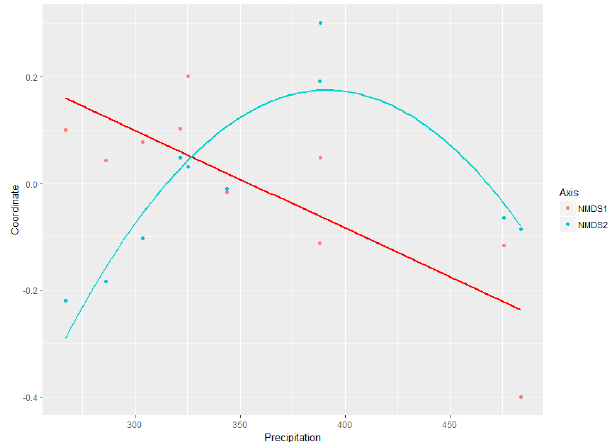
Fig 5 . Coordinates of 10×10 km UTM squares of the systematic sampling (see Methods) on NMDS space of Figure 3 against precipitation. Dots, empirical data; lines fitted regression lines between NMDS coordinates in each axis and precipitation (see